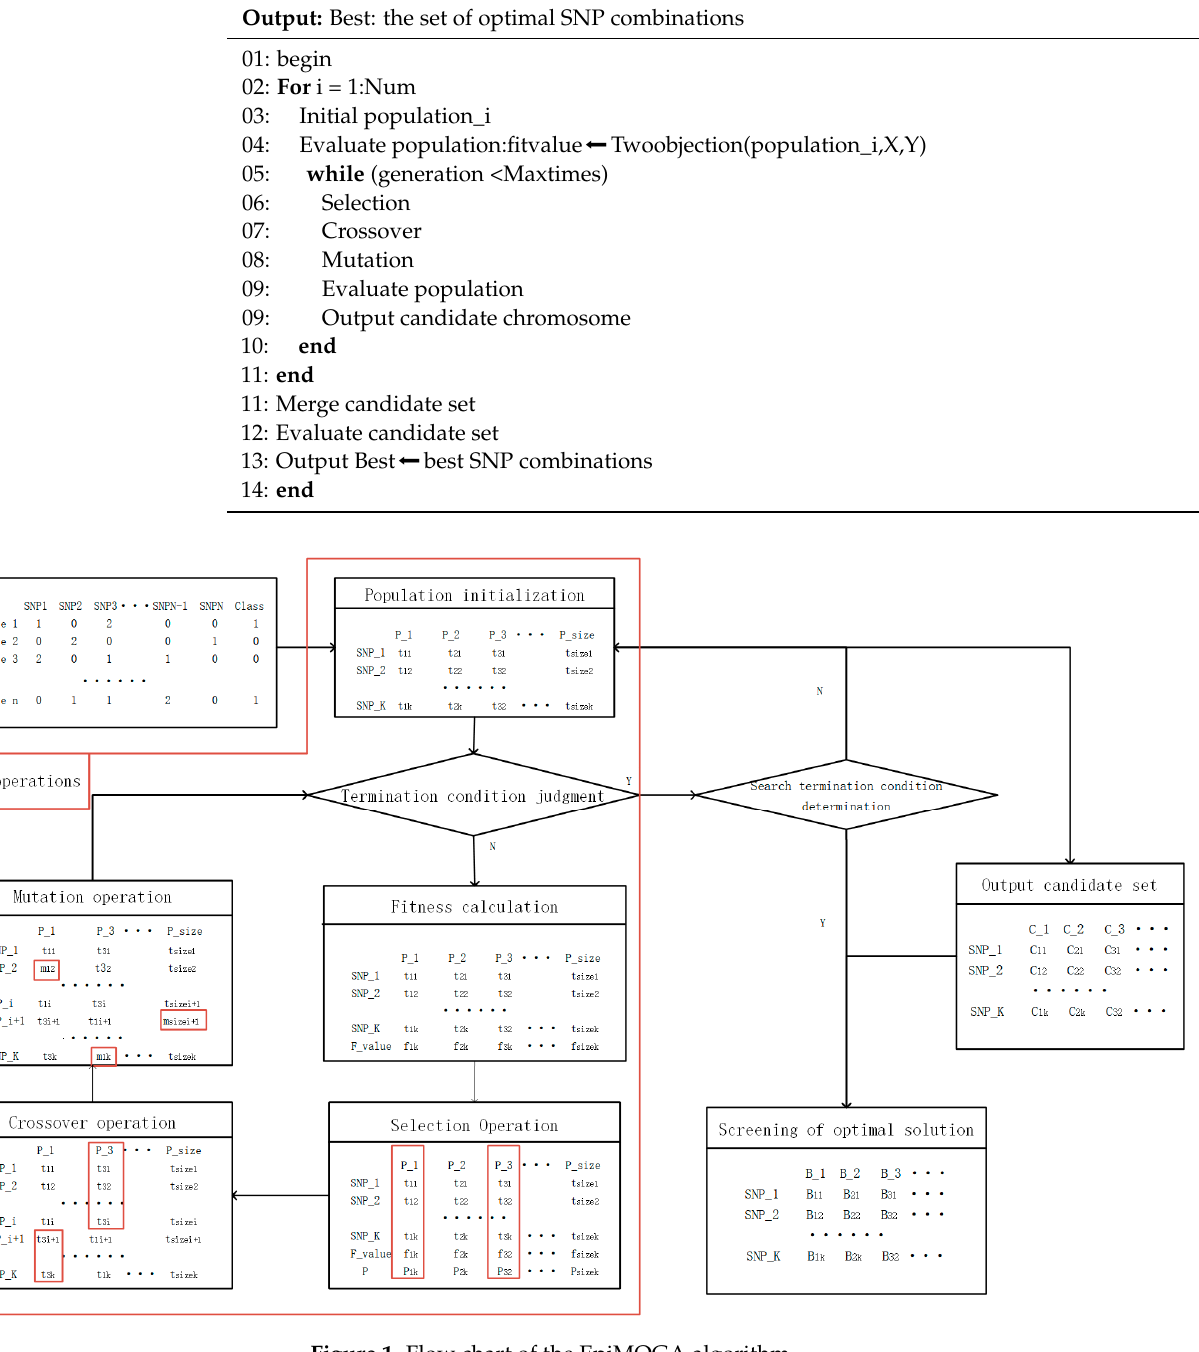
Figure 1. Flow chart of the EpiMOGA algorithm. Algorithm 1. EpiMOGA pseudocode